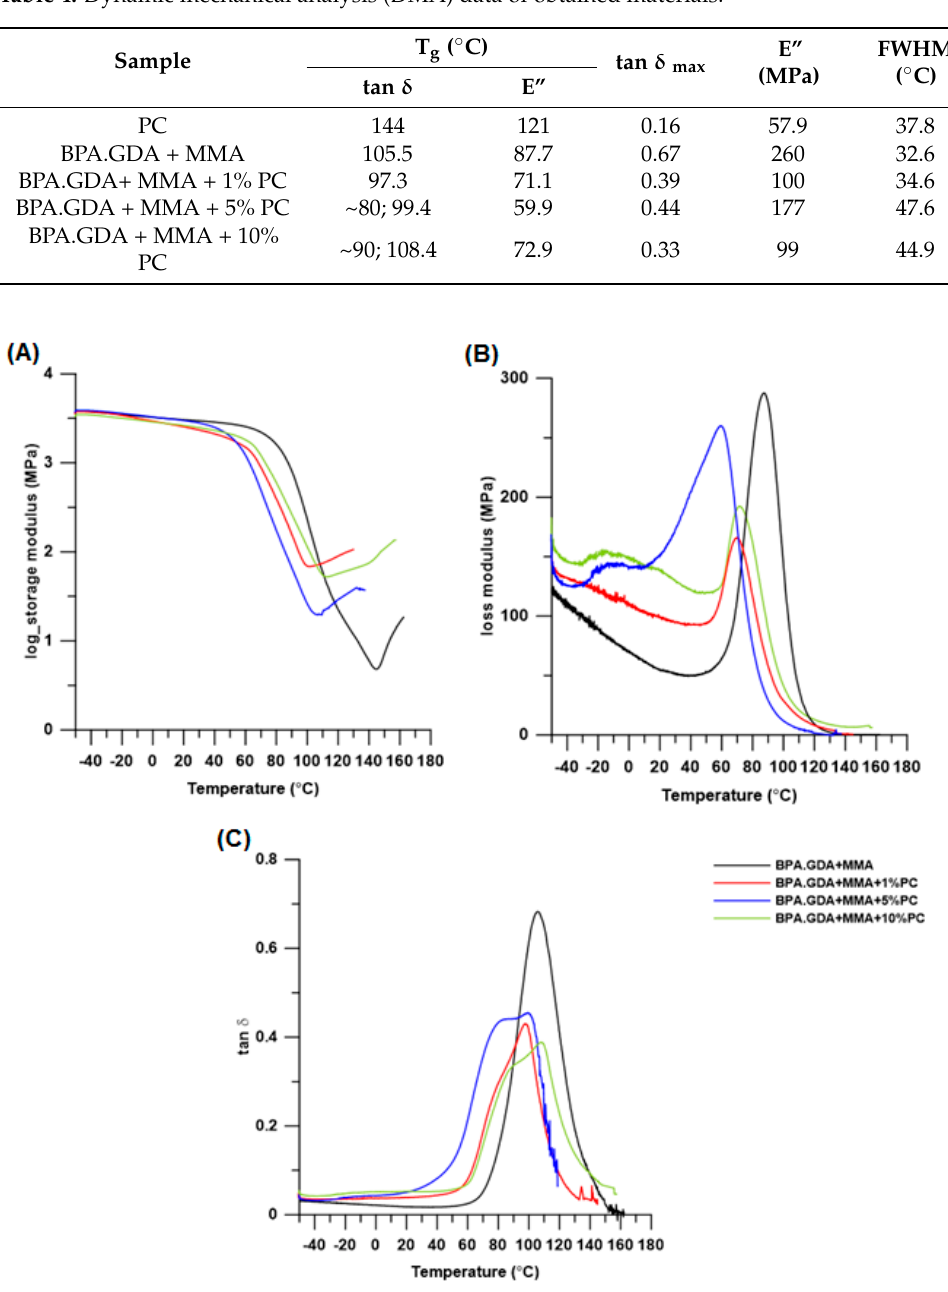
Figure 10. DMA curves for BPA.GDA + MMA blends: Storage modulus (E’) ( A ), loss modulus (E”) ( B ) and damping factor (tan δ ) ( C ).